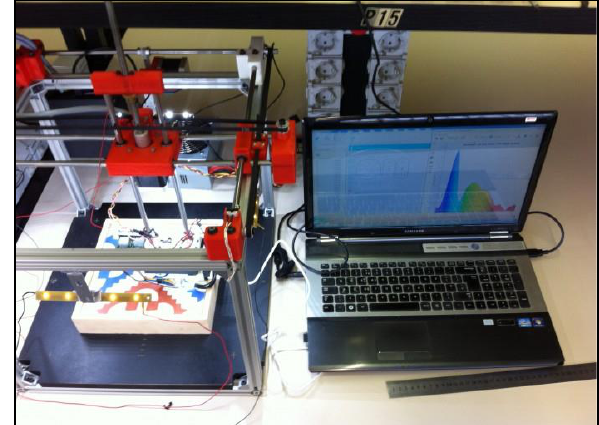
Figure 1 . The XYZ positioning system after adaptations for carry on colorimetric analyses on hydraulic tiles.